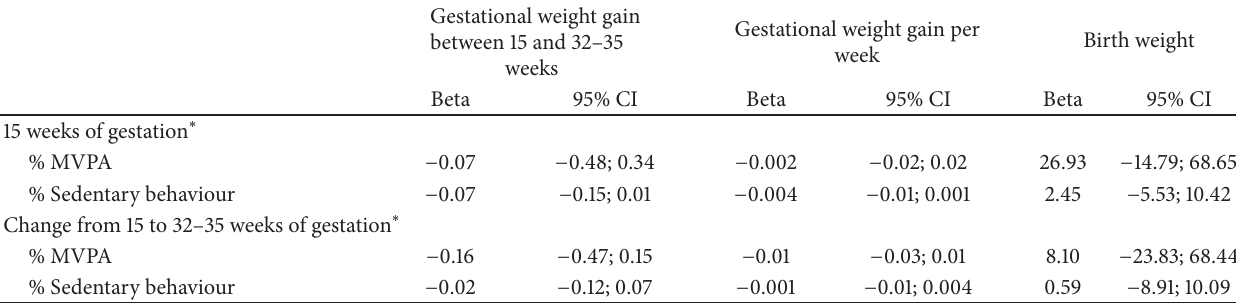
Table 2: Associations between PA, sedentary behaviour, gestational weight gain, and birth